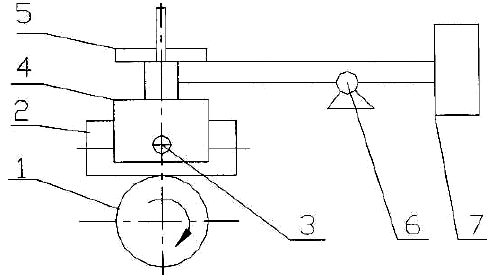
Fig. 1. Scheme of the device for tests on wear according to the scheme of cross cylinders: 1 - shaft; 2 - sample; 3 - screw; 4 - mandrel; 5 - cargo; 6 - support; 7 -